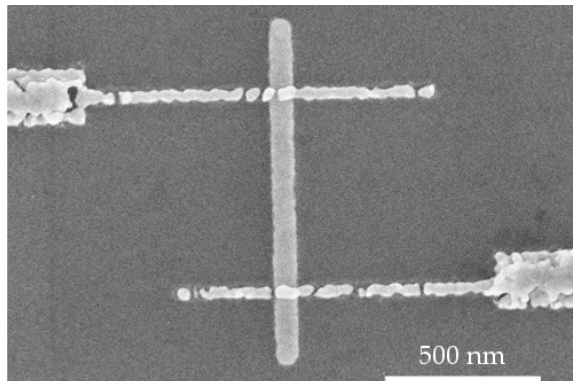
Figure 9. Scanning electron micrograph of a Ni ‐ SiO 2 ‐ Ni device where strong agglomeration occurs after a forming gas anneal (FGA) at 400 °C for 30 min leading to the breaks in the source and drain electrodes (nearly horizontal broken lines).